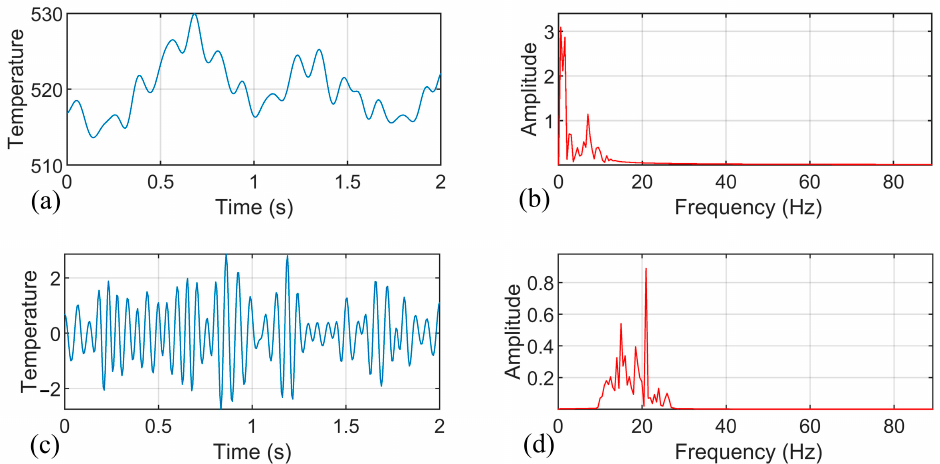
Figure 7. Temperature signal component of welds with tunnel defects formed after sudden perturbation: ( a ) Temperature signal component decomposed by wavelet packet at node 7; ( b ) Spectrum of temperature signal component at node 7; ( c ) Temperature signal component decomposed by wavelet packet at node 8; and ( d ) Spectrum of temperature signal component at node 8.